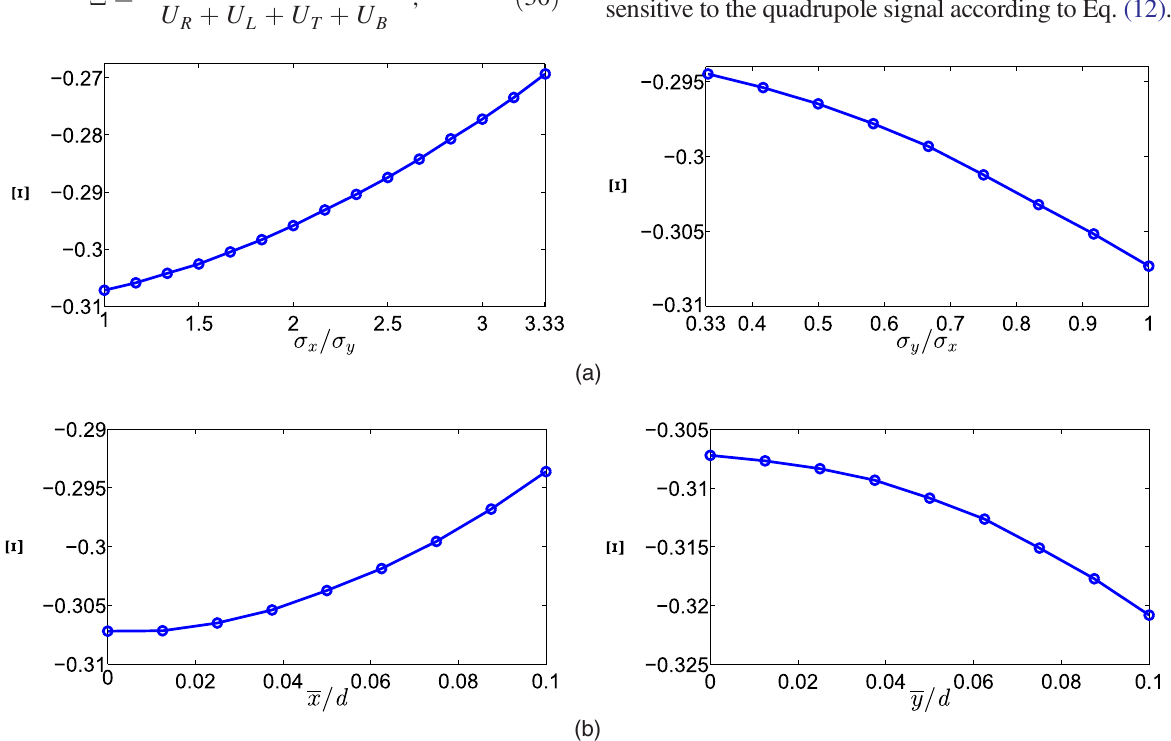
FIG. 12. (a) Quadrupole signal Ξ for a centered beam as a function of the beam size; (left) as a function of σ x = σ y , σ y ¼ 7 . 5 mm; (right) as a function of σ y = σ x , σ x ¼ 15 mm. (b) Quadrupole signal Ξ for a round beam ( σ x ¼ σ y ¼ 7 . 5 mm) as a function of the beam position; (left) as a function of ¯ x=d , ¯ y ¼ 0 ; (right) as a function of ¯ y=d , ¯ x ¼ 0